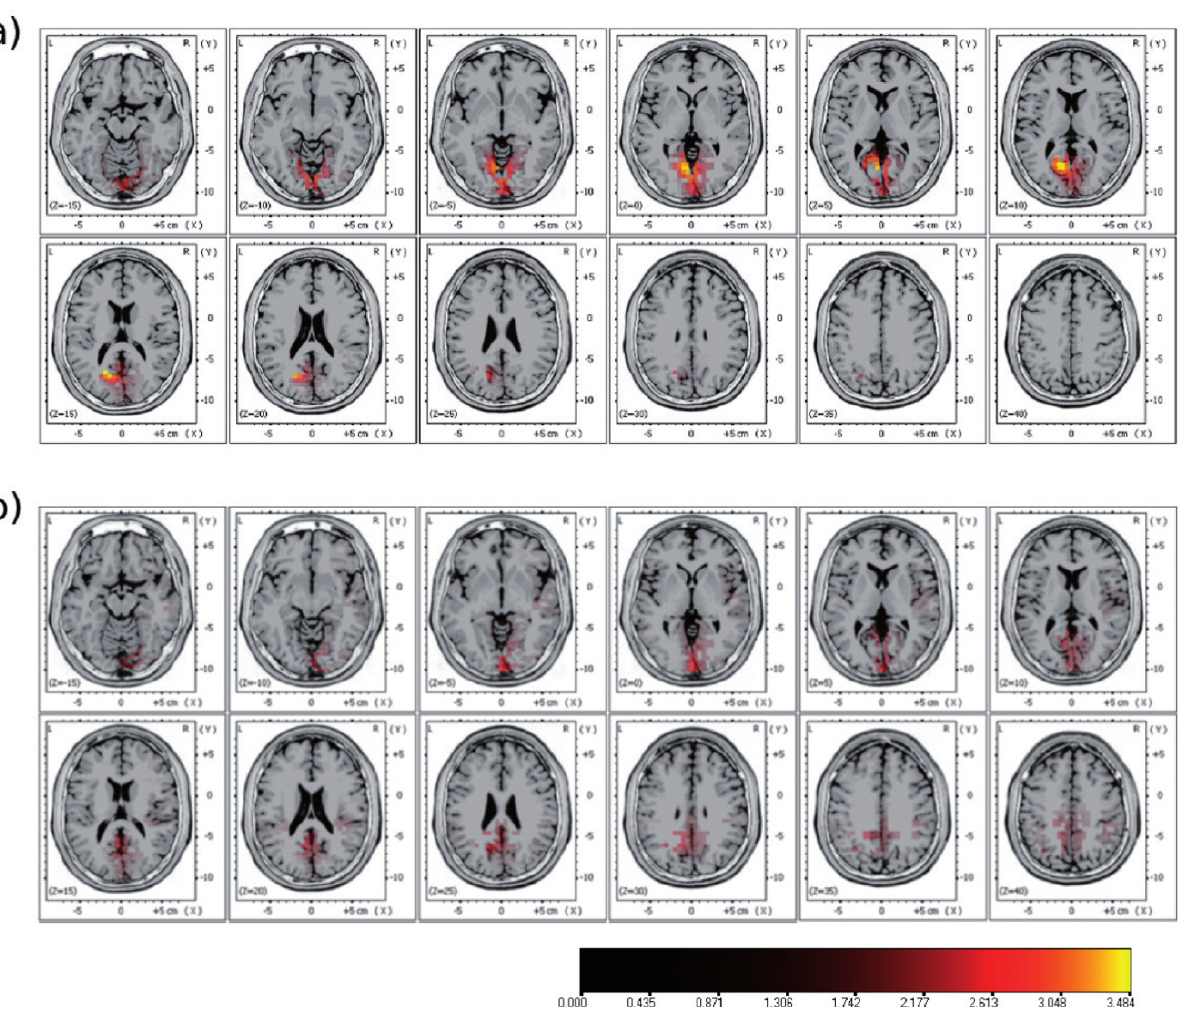
Figure 8. SCP-based source localization within the interval 2,000—5,000 ms post stimulus of a single subject. (a) SCPs recorded inside the scanner without fMRI acquisition, (b) SCPs recorded while acquiring fMRI